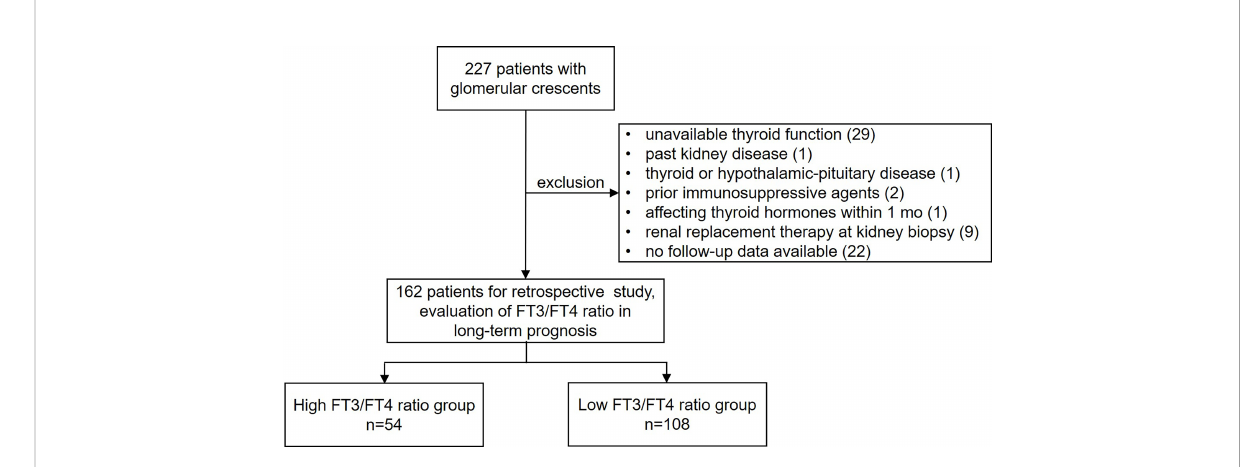
FIGURE 1 Overall design of the